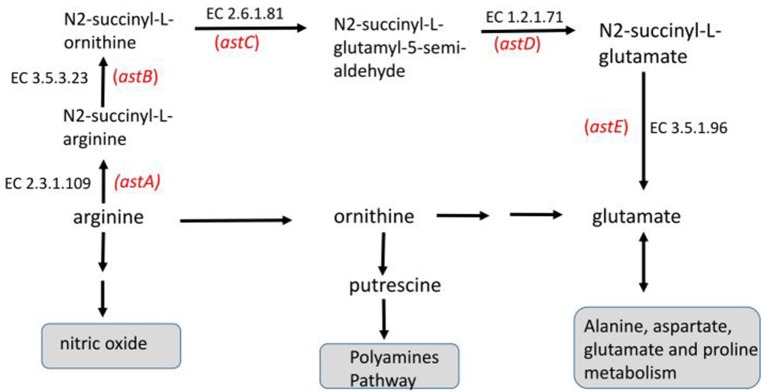
Arginine catabolic routes mapping the sub-set of five enzymes codified by the genes dysregulated in the microarray data corresponding to the stationary phase of batch culture with the wild type E. coli strain (first row, Experiment B, Table 2). The enzymes are indicated by their Enzyme Commission (EC) number, while the names of the genes that codify them are indicated in red. The diagram is a simplified adaptation based on KEGG Pathways (map 00330) after Ontology DAVID 6.8 software processing (FDR = 8 × 10−4).